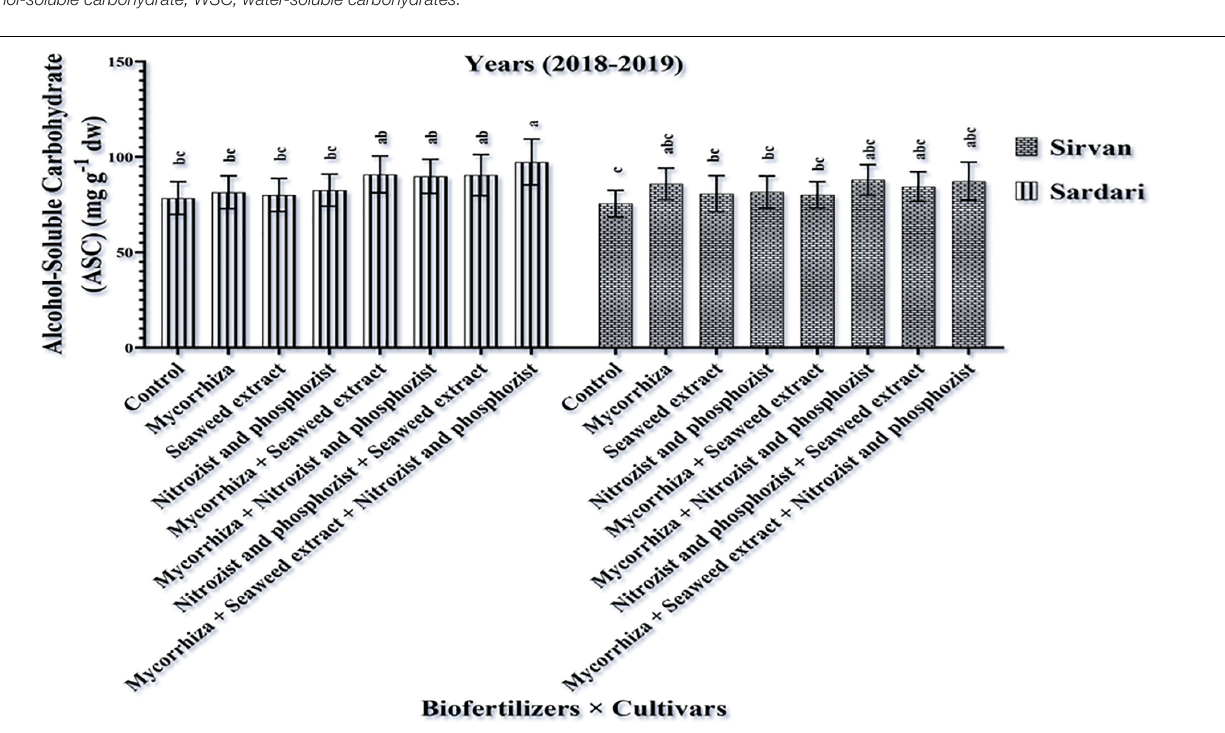
FIGURE 8 | Mean comparisons of the dual interaction effect of biofertilizers × cultivars on alcohol-soluble carbohydrate content of wheat plant in 2018–2019. Means in each column followed by similar letter(s) are not significantly different at 1% probability level by the LSD test. TABLE 10 | Mean comparisons of simple effects of bio-fertilizers on some traits in the wheat plant in 2018–2019.